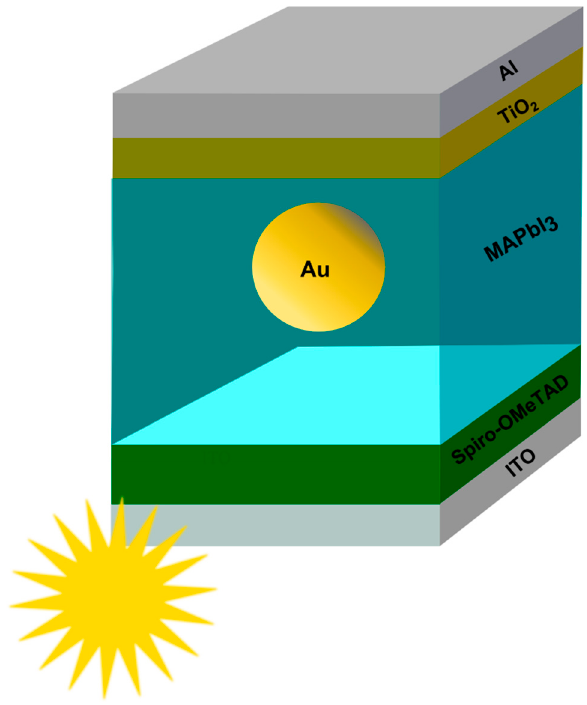
Figure 1. The schematic of the perovskite solar cell with a Au nanoparticle (NP).